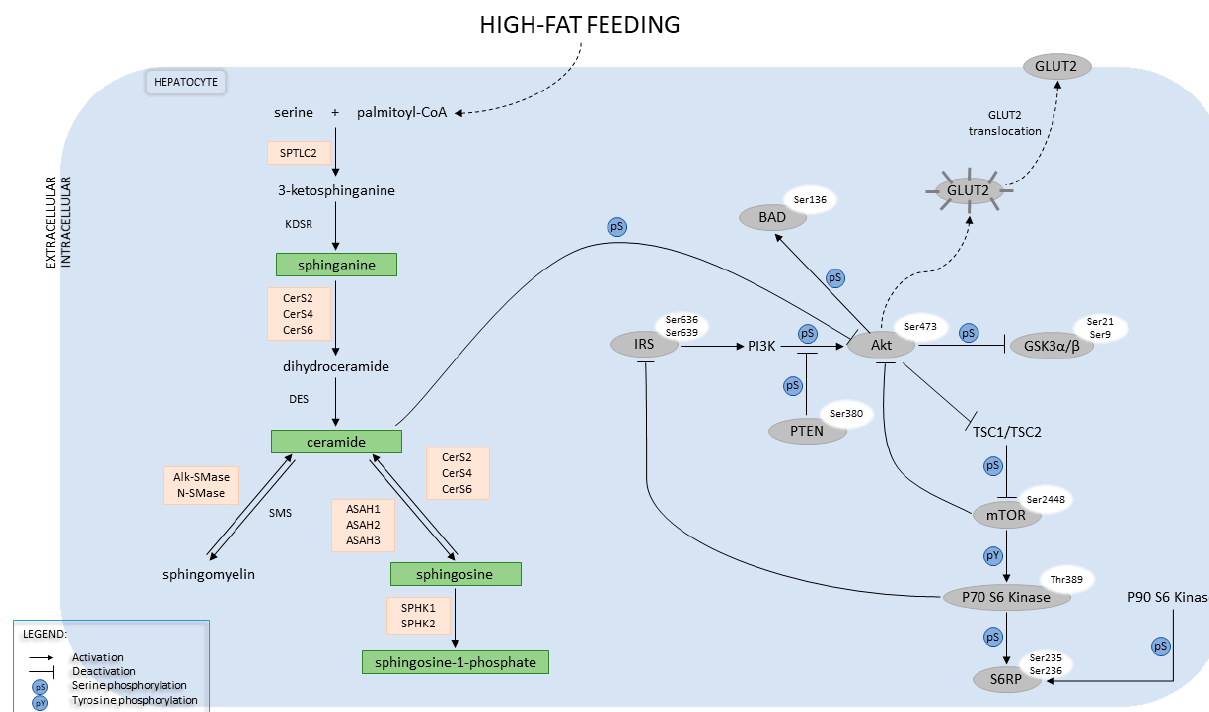
Scheme 1. Graphical presentation of the relationship between PI3K/Akt/mTOR and sphingolipid pathways in the insulin resistance development induced by high-fat feeding.